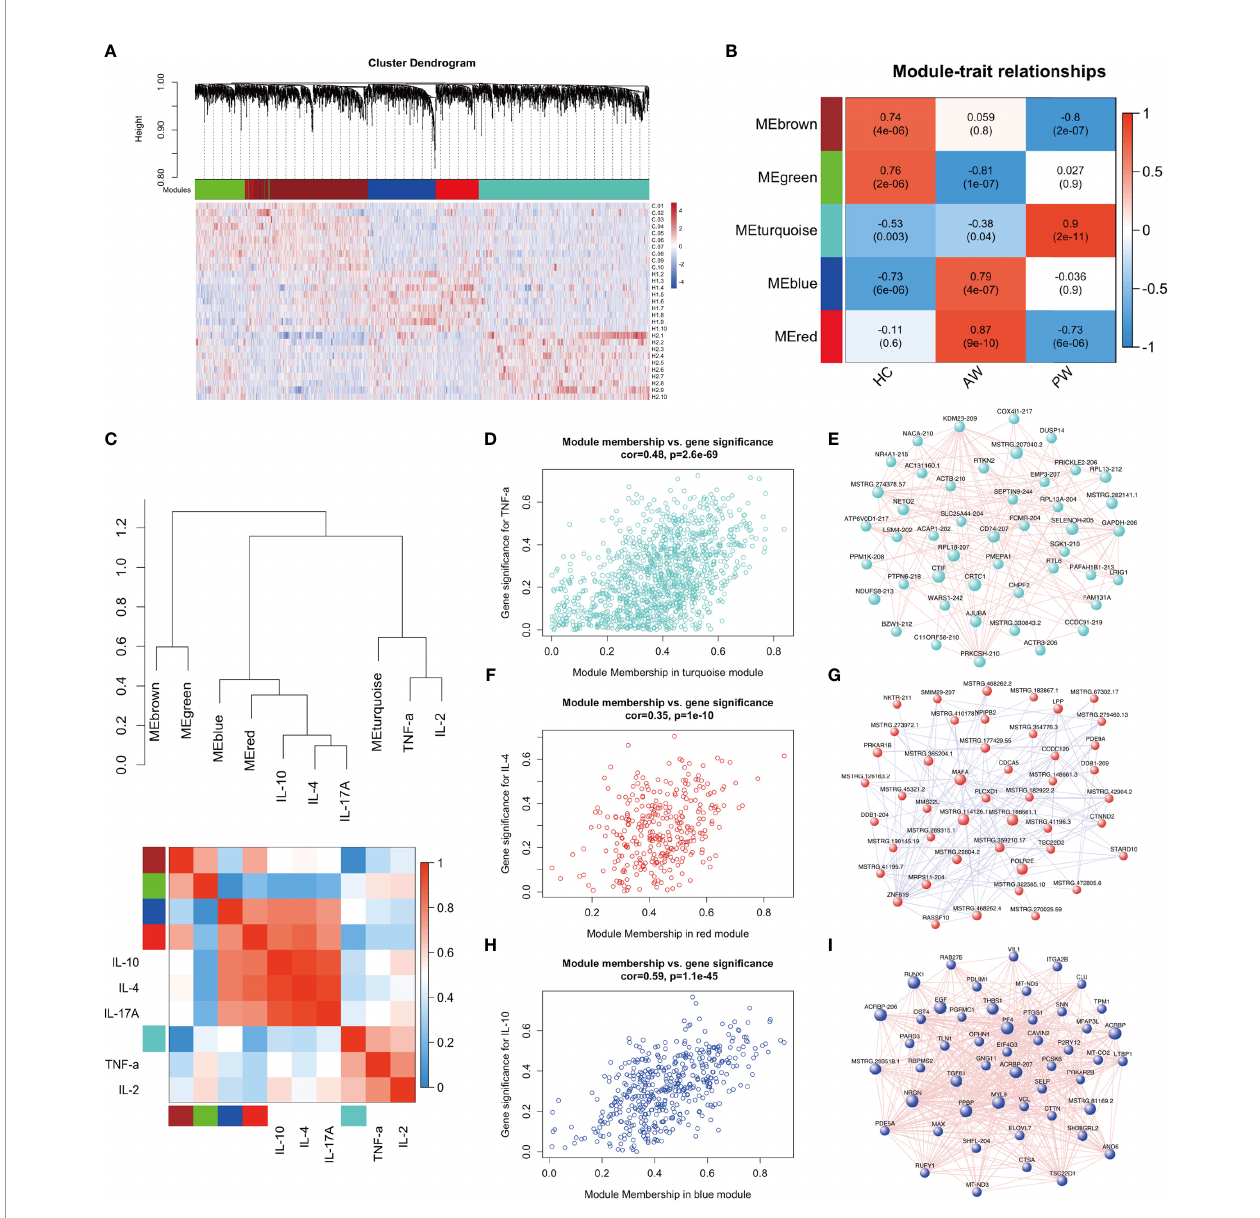
FIGURE 4 | WGCNA of plasma exosome samples uncovered dynamic changes of exosome mRNAs and lncRNAs signatures during substance withdrawal. (A) Hierarchical cluster dendrogram using WGCNA analyzing RNA sequencing data. A total of 5 modules were identi fi ed after 0.25 threshold merging. (B) Module trait correlation analysis revealed that 5 key modules were signi fi cantly correlated with Heroin AW and Heroin PW. (C) The eigengene dendrogram and heatmap showed the relevancies of cytokines and identi fi ed RNA-seq modules. TNF-a, IL-2, IL-4, IL-10 and IL-17A were selected. (D) The correlation and connectivity of the turquoise module and TNF-a (r = 0.48, p = 2.6E-69). (E) The hub-gene network of turquoise module. The network of Top 50 lncRNAs/mRNAs (Rankings related to turquoise module) were showed. (F) The correlation and connectivity of the red module and IL-4 (r = 0.35, p = 1.1E-10). (G) The hub-gene network of red module. The network of Top 50 lncRNAs/mRNAs (Rankings related to red module) were showed. (H) The correlation and connectivity of the blue module and IL-10 (r = 0.59, p = 1.1E-45). (I) The hub-gene network of blue module. The network of Top 50 lncRNAs/mRNAs (Rankings related to blue module) were